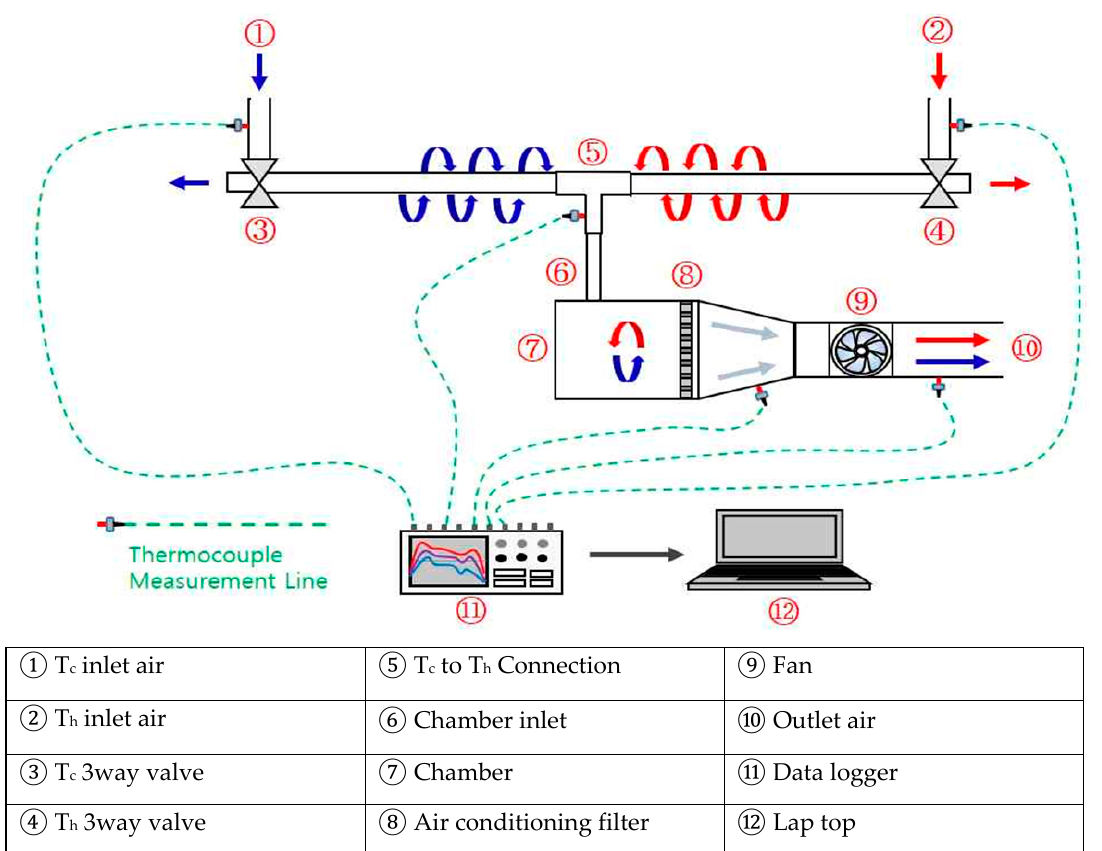
Figure 8. Photograph of an indirect experimental device with a heater core.